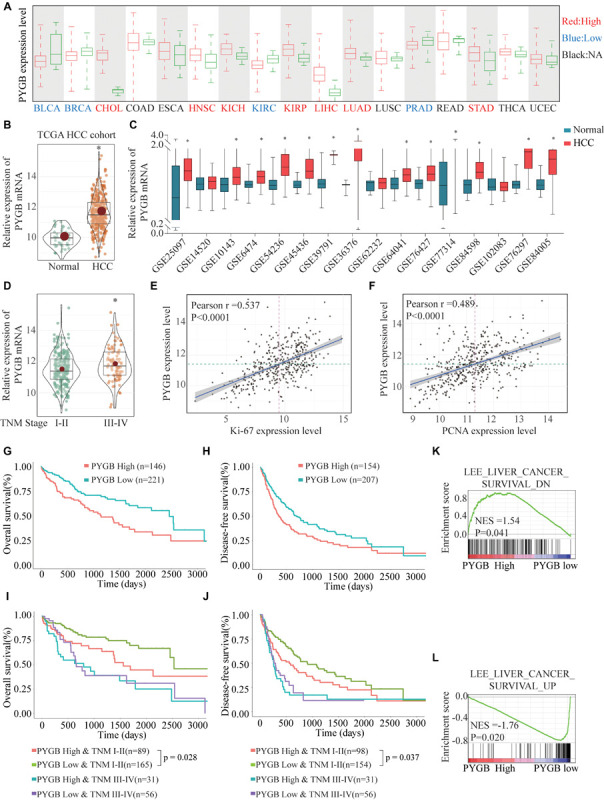
The PYGB mRNA expression and its relationship with clinico-pathological features of HCC patients were analyzed using TCGA cohort and GEO cohort. (A) The mRNA expression of PYGB in a series of cancer tissues and the corresponding normal tissues was analyzed in TCGA cohort. BLCA, bladder urothelial carcinoma; BRCA, breast cancer; CHOL, cholangiocarcinoma; COAD, colon cancer; ESCA, esophagus cancer; HNSC, head and neck squamous cell carcinoma; KIRC, renal cancer; KIRC, kidney renal clear cell carcinoma; KIRP, kidney renal papillary cell carcinoma; LIHC, liver cancer; LUAD, lung cancer; LUSC, lung squamous cell carcinoma; PRAD, prostate adenocarcinoma; READ, rectal cancer; STAD, stomach cancer; THCA, thyroid cancer; UCEC, uterine corpus endometrial carcinoma. (B) The mRNA expression of PYGB in HCC tissues and normal liver tissues was analyzed in TCGA HCC cohort. (C) The mRNA expression of PYGB was analyzed in HCC tissues and normal liver tissues in 16 GEO HCC datasets. (D) The mRNA expression of PYGB was analyzed in patients with different TNM stages in TCGA HCC cohort. (E,F) The relationships between PYGB mRNA expression and the mRNA expression levels of Ki-67 and PCNA were assessed by Pearson analysis. (G,H) Kaplan–Meier analysis the overall survival (OS) and disease-free survival (DFS) in HCC patients with high or low PYGB expression in TCGA HCC cohort. (I,J) Hierarchical analyses of OS and DFS in HCC patients with high or low expression of PYGB based on TNM stages. (K,L) Gene Set Enrichment Analysis (GSEA) of survival up- and down-associated signature genes in HCC patients with high or low PYGB expression in TCGA HCC cohort. *p < 0.05.